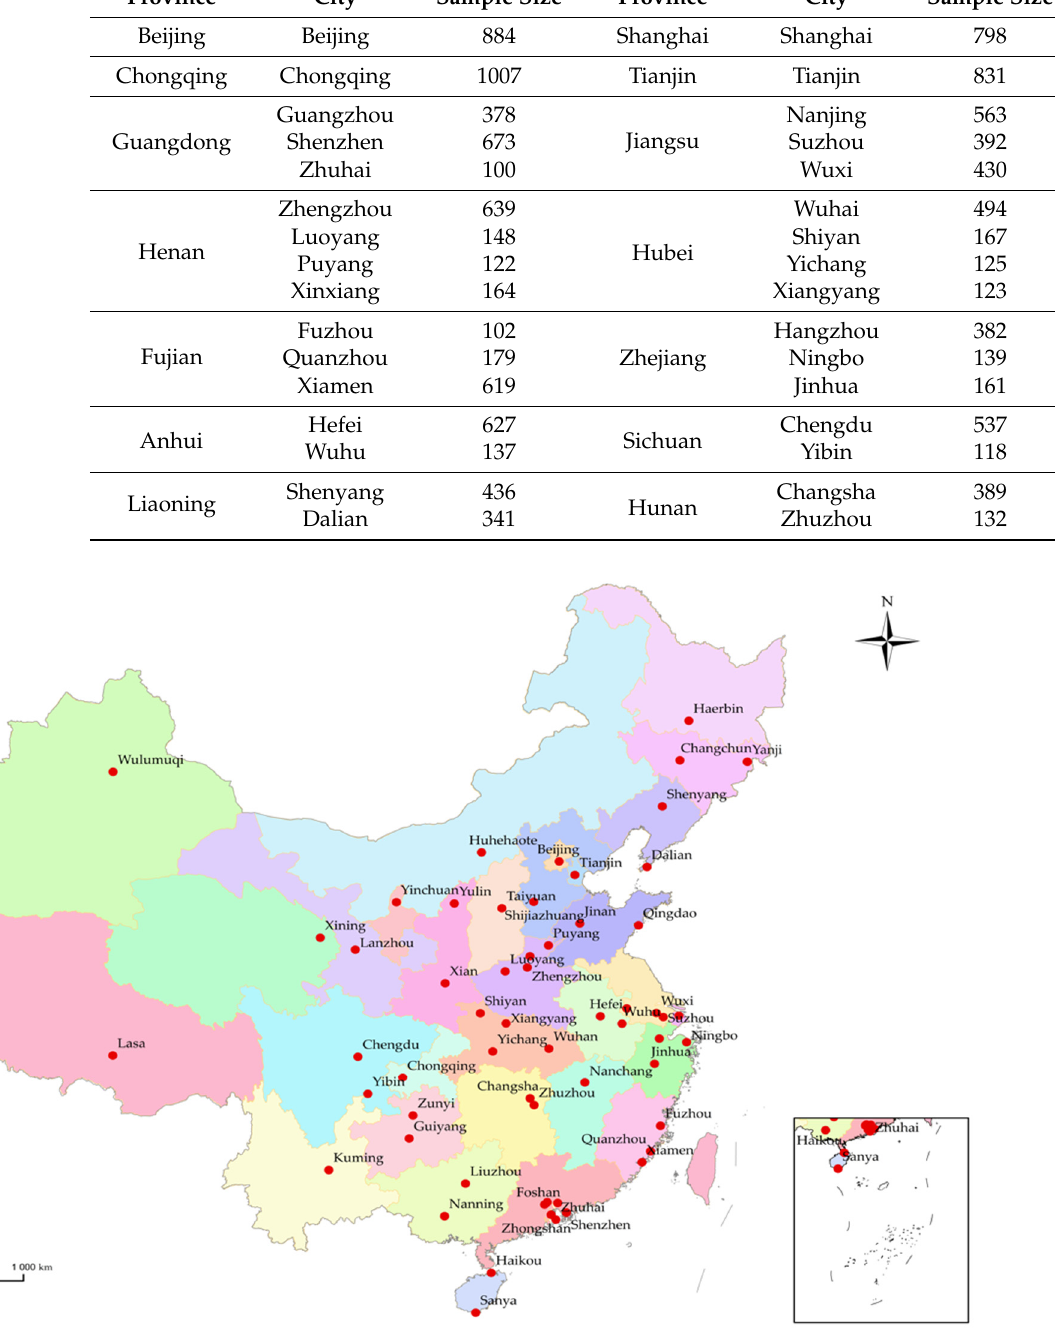
Figure 1. Location map of the sampled